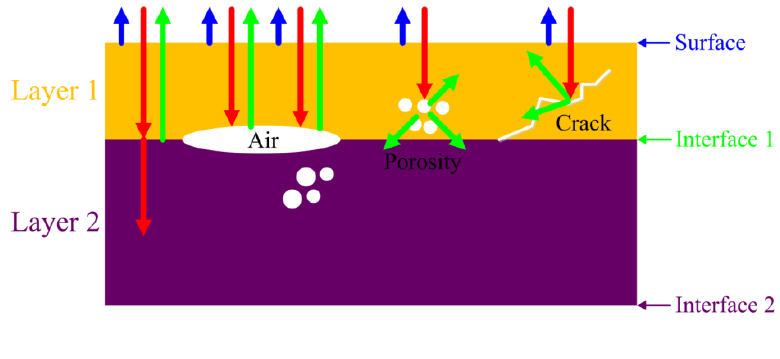
Figure 1. Schematic propagation of the ultrasound through materials with different